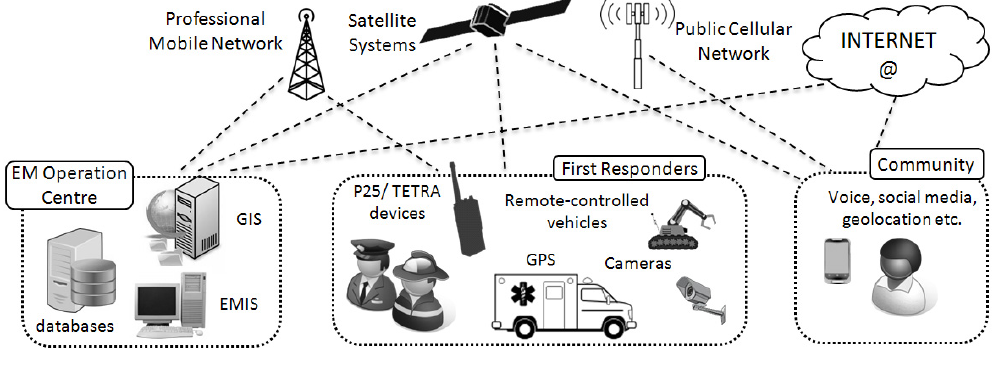
Figure 1. Example of technologies involved in the Response